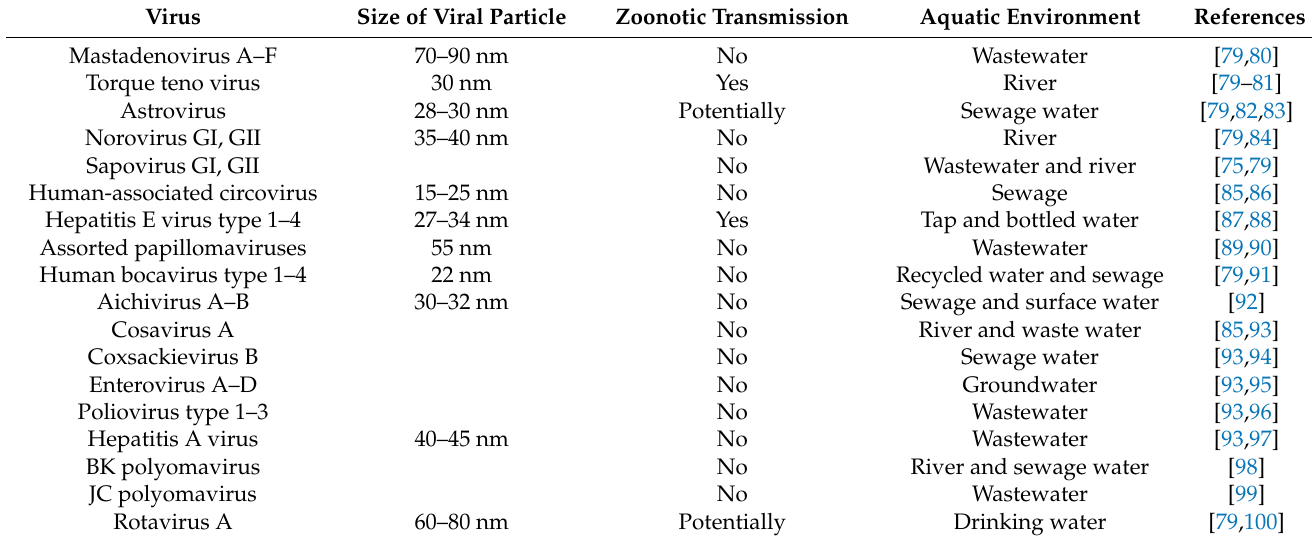
Table 1. Human pathogenic viruses detected in the aquatic